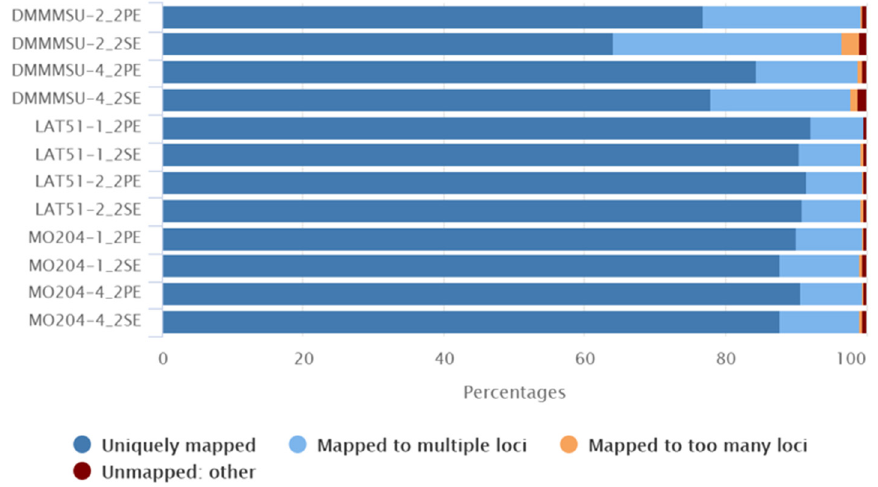
Figure 2. Summary of STAR alignment statistics of Bombyx mori RNA-seq reads to the reference genome. (PE: Paired-end reads, SE: Single-end reads). Generated using STAR.log files and MultiQC [23].